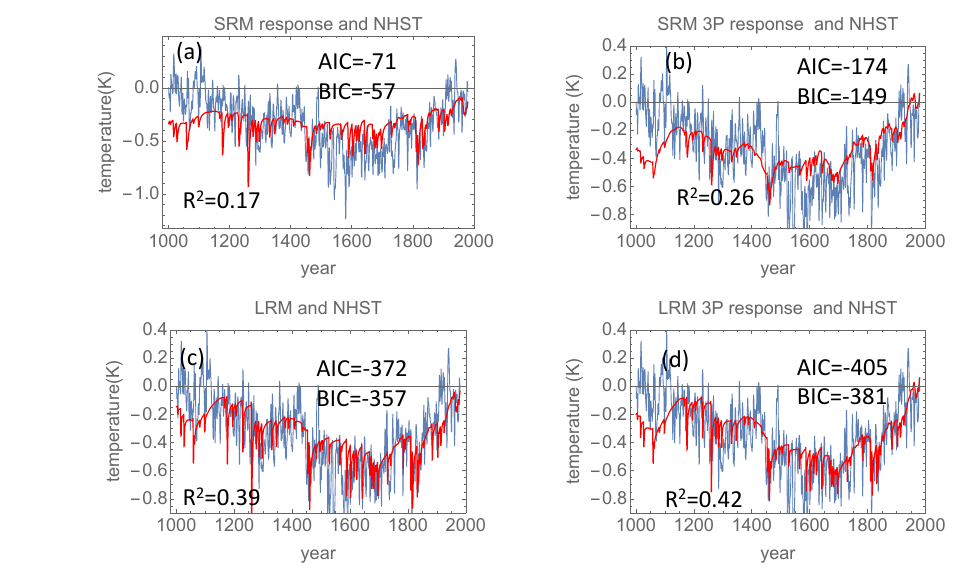
Figure 6. Blue curve in all panels is the Moberg reconstructed temperature for the Northern Hemisphere plotted for the interval 1000– 1979CE. Panel (a) : the SRM regressed signal Q ( t ) defined in Eq. (5), with F being the SRM filter and F ( t ) the total forcing. Panel (b) : the SRM 3P regressed signal according to Eq. (1) without AMO and ENSO as predictors. Panel (c) : the LRM regressed signal Q ( t ) defined in Eq. (5), with F being the LRM filter. Panel (d) : the LRM 3P regressed signal according to Eq. (1) without AMO and ENSO as